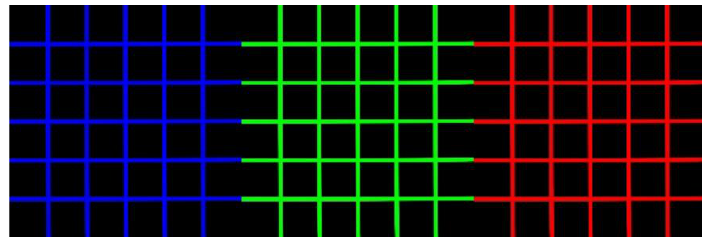
Figure 11. Test Images.